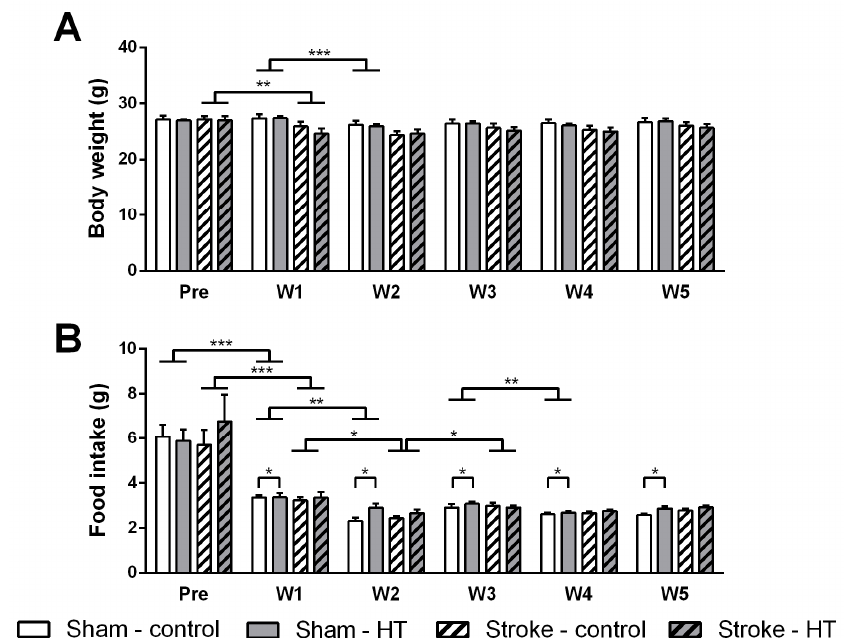
Figure 2. Effect of hydroxytyrosol (HT) diet on body weight and food intake. ( A ) Body weight of both dietary stroke groups decreased post-stroke versus pre-stroke ( p < 0.002). Sham mice lost body weight comparing week 1 with week 2 ( p < 0.001), with no effect in the upcoming weeks. ( B ) Food intake of both stroke and sham mice decreased over time comparing pre-surgery and the first week after surgery (Sham: p < 0.001; Stroke: p < 0.001). Sham mice had a lower food intake comparing week 1 to week 2 ( p < 0.006) and also week 3 to week 4 ( p < 0.009). Sham mice on HT diet had a higher food